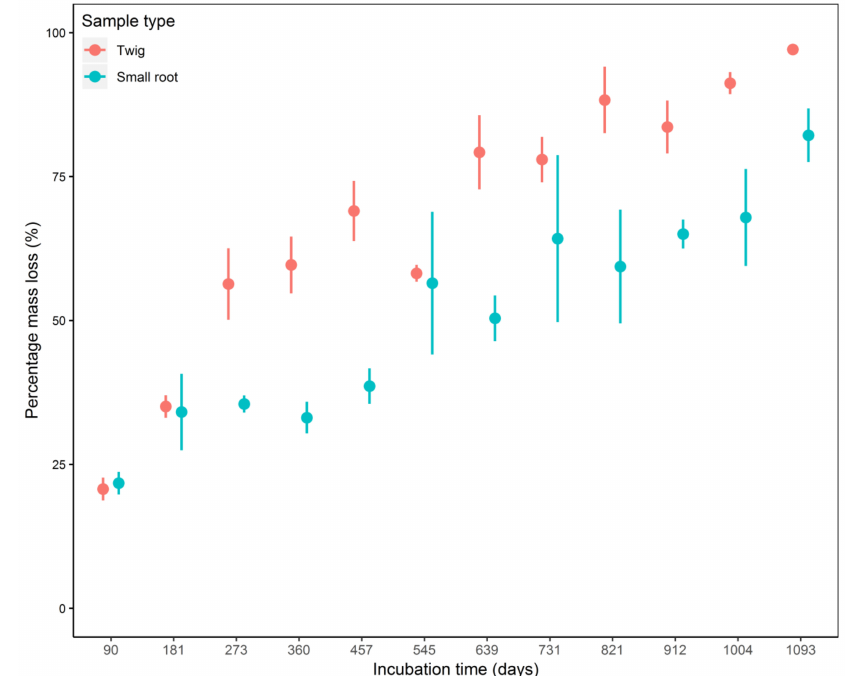
Figure 2. Percentage mass loss for twig and small root litter of Parashorea chinesnsis Wang Hsie litter monitored through a litter bag experiment for 1093 days in Mengla county, Xishuangbanna, China. Red = twigs; blue = small root. Dots represent the mean for samples collected at each harvest and error bars represent the standard errors ( n =